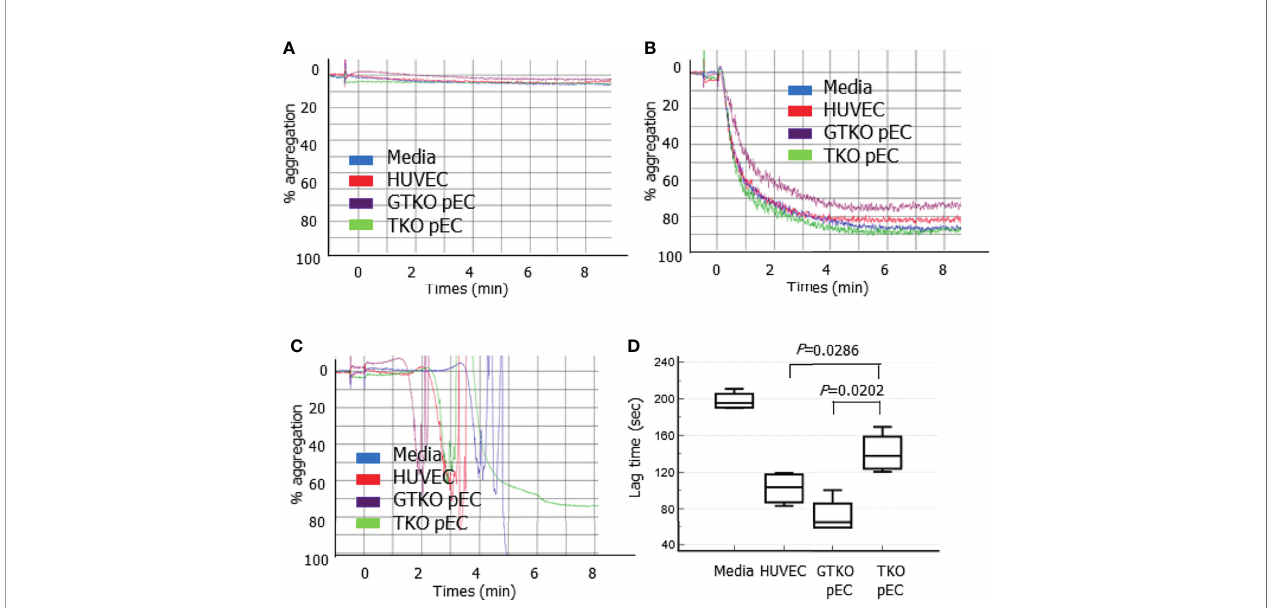
FIGURE 5 | Platelet aggregation measured by a Chrono-log model 700 aggregometer. Various cells, human umbilical vein cells (HUVEC), and primary porcine endothelial cells (pEC) from alpha-1,3-galactosyltransferase gene-knockout ( GT KO) pigs and from triple knockout (TKO) pigs, were added to human platelet-rich plasma (PRP) and aggregation was measured by 8 min (A) . Adenosine diphosphate ( fi nal concentration 10 µM) was added to PRP with the cells, and aggregation was measured (B) . CaCl 2 ( fi nal concentration 5 mM) was added to PRP with the cells, and aggregation was measured. The lag time before the formation of detectable aggregation in each condition was analyzed (C) . A representative aggregometer fi gure in three independent experiments is shown on each panel (A, C) . The cumulative data of lag time from three independent recalci fi cation experiments are presented as a box-and-whisker plot (D)